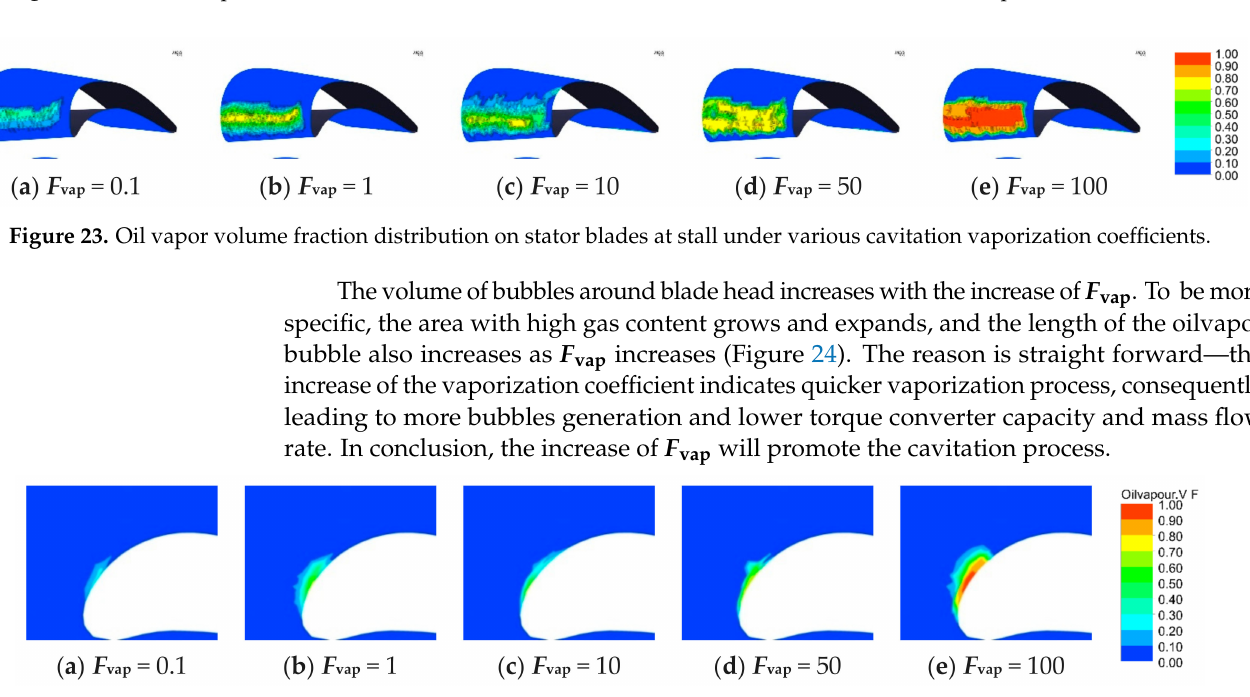
Figure 22. The 10% vapor volume fraction distribution in stator domain at stall under various cavitation vaporization coefficients.